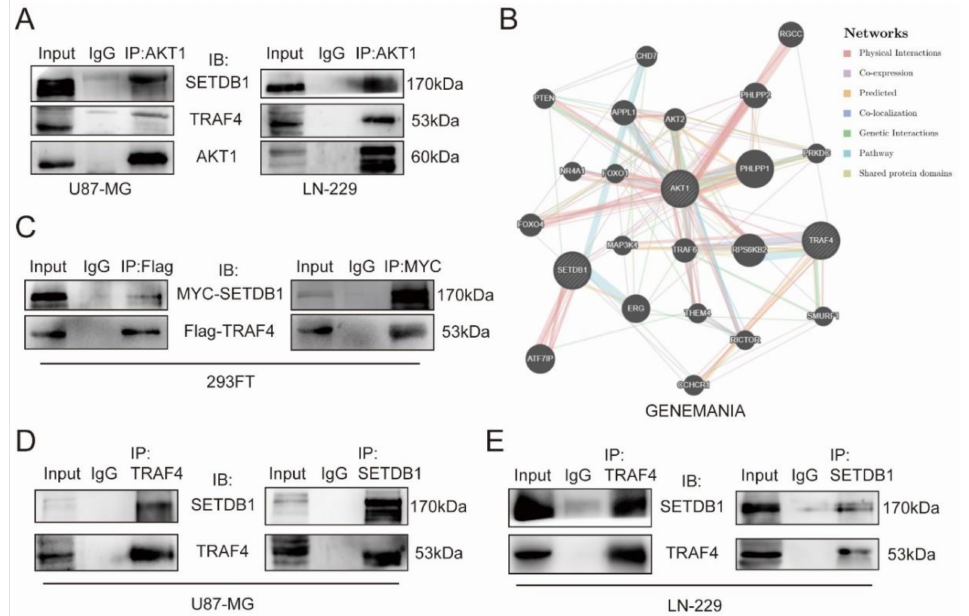
Figure 4. TRAF4 interacts with SETDB1. ( A ) Whole-cell extracts (WCE) of U87-MG and LN-229 cells were collected and subjected to immunoprecipitation assays (AKT1 for IP) and immunoblotting. The interaction of AKT1 with TRAF4 and SETDB1 in glioblastoma cells was examined. ( B ) Protein– protein interaction (PPI) analysis in the online tumor databases GeneMANIA. ( C ) 293FT cells infected with Flag-TRAF4 and MYC-SETDB1 were immunoprecipitated with anti-Flag antibody/anti-MYC antibody, followed by immunoblotting. The interaction of exogenously expressed Flag-TRAF4 and MYC-SETDB1 in 293FT was examined. ( D , E ) Whole-cell extracts (WCE) of ( D ) U87-MG and ( E ) LN- 229 cells were collected and subjected to immunoprecipitation assays (TRAF4/SETDB1 for IP) and immunoblotting. The interaction of TRAF4 and SETDB1 in glioblastoma cells was